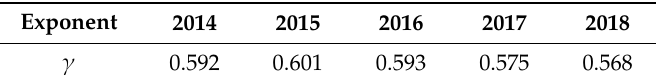
Table 4. γ for each year.